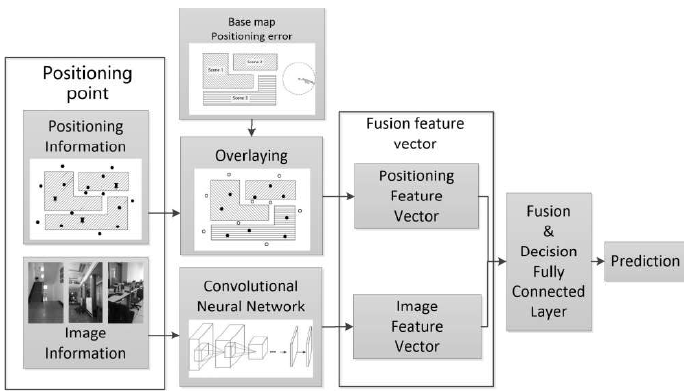
Figure 2. The algorithm flow chart for deep learning scene recognition method based on localization enhancement.